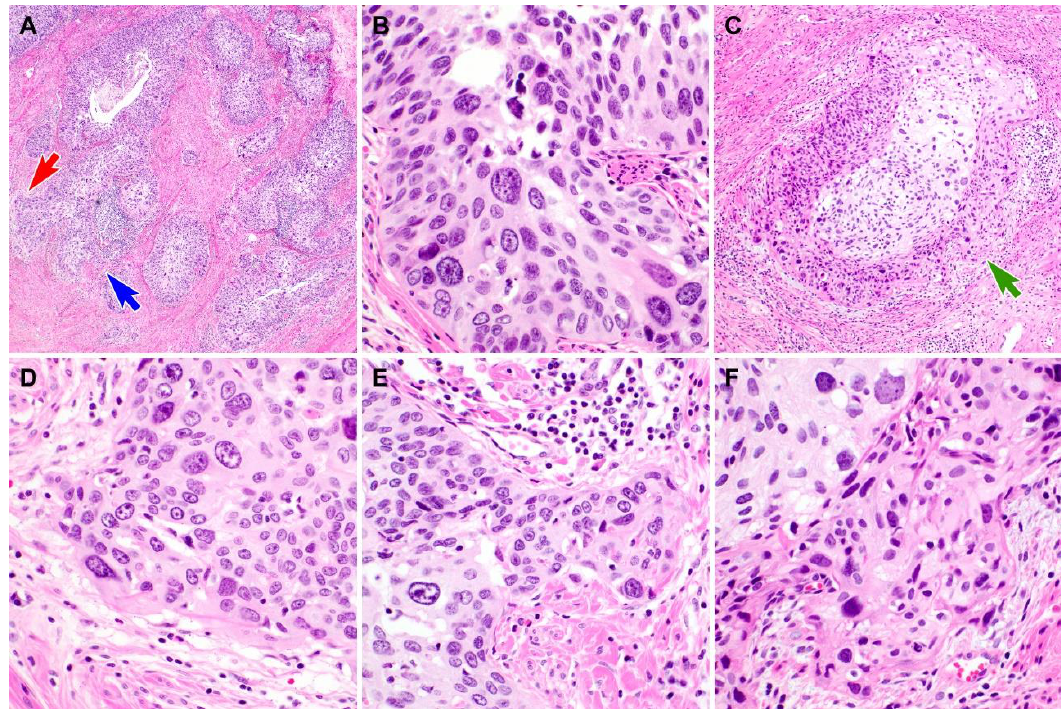
Figure 5. Histological features of squamous cell carcinoma associated with pleomorphic high-grade squamous intraepithelial lesion (PHSIL). ( A ) PHSIL extensively involves multiple endocervical glands. ( B ) PHSIL involving the endocervical glands displays marked nuclear enlargement and pleomorphism and red conspicuous nucleoli. ( C ) The largest invasive focus measures < 1 mm. ( D – F ) High-power magnifications of microscopic invasive foci indicated by ( D ) red and ( E ) blue arrows in image ( A ) and by a ( F ) green arrow in image ( C ). Stromal desmoplasia and inflammatory infiltrates are associated. Hematoxylin and eosin staining. Original magnification: ( A ) = 40×, ( B ) = 400×, ( C ) = 100×, ( D – F ) = 200×.